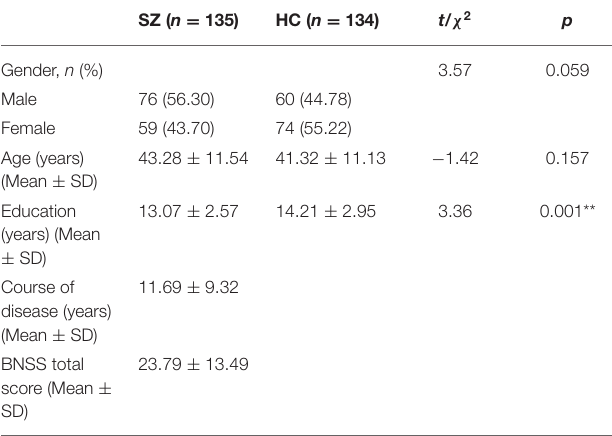
TABLE 1 | Demographic and clinical data for the schizophrenia group and the healthy control group ( N =